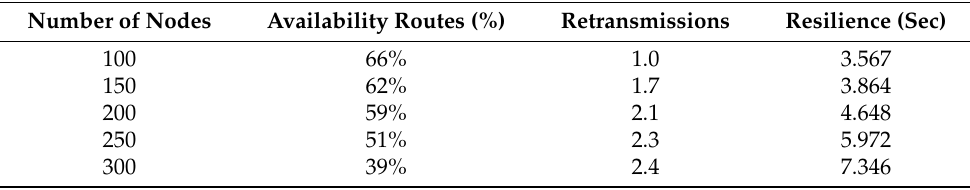
Table 6. Performance metrics with relevant impact on energy for PEGASIS under normal